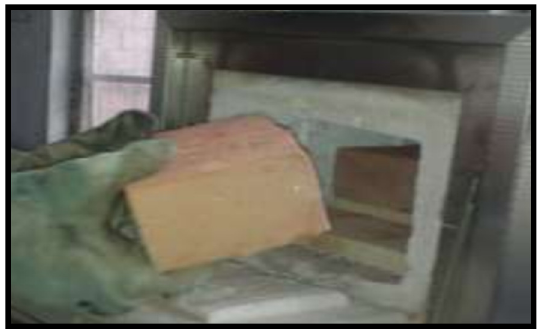
Fig. 7: Brick specimen after burning in electric oven Table 2: Gradual increase in burning temperature with time Timing